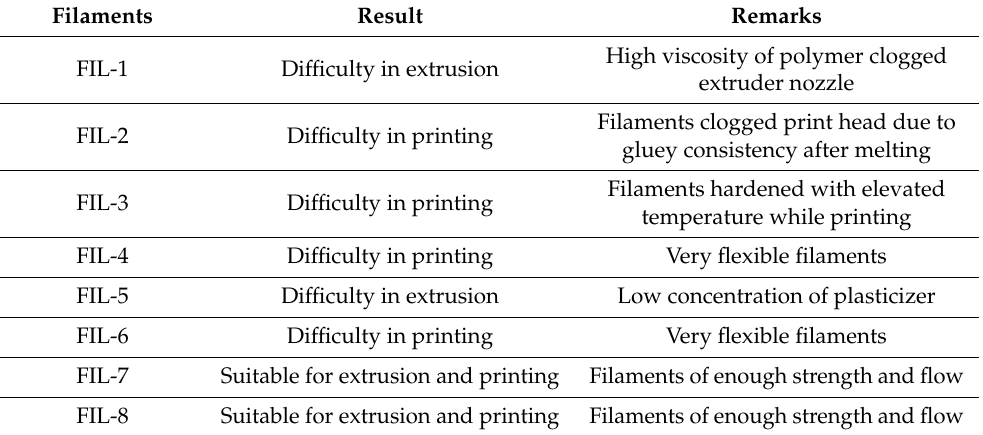
Table 2. Properties of filaments obtained from the hot melt